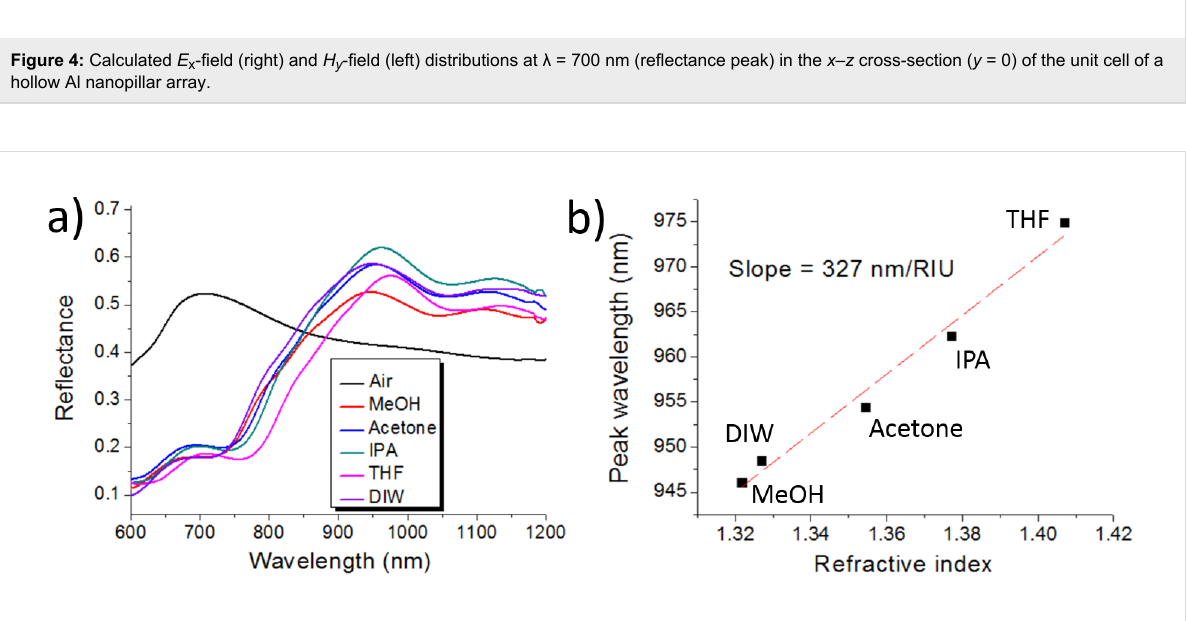
Figure 5: a) Reflectance of hollow, closed, Al nanopillar arrays for different superstrate media: air, methanol (MeOH), acetone, isopropanol (IPA), tetrahydrofuran (THF) and deionized water (DIW). b) Spectral position of the reflectance maximum peak as a function of the liquid refractive